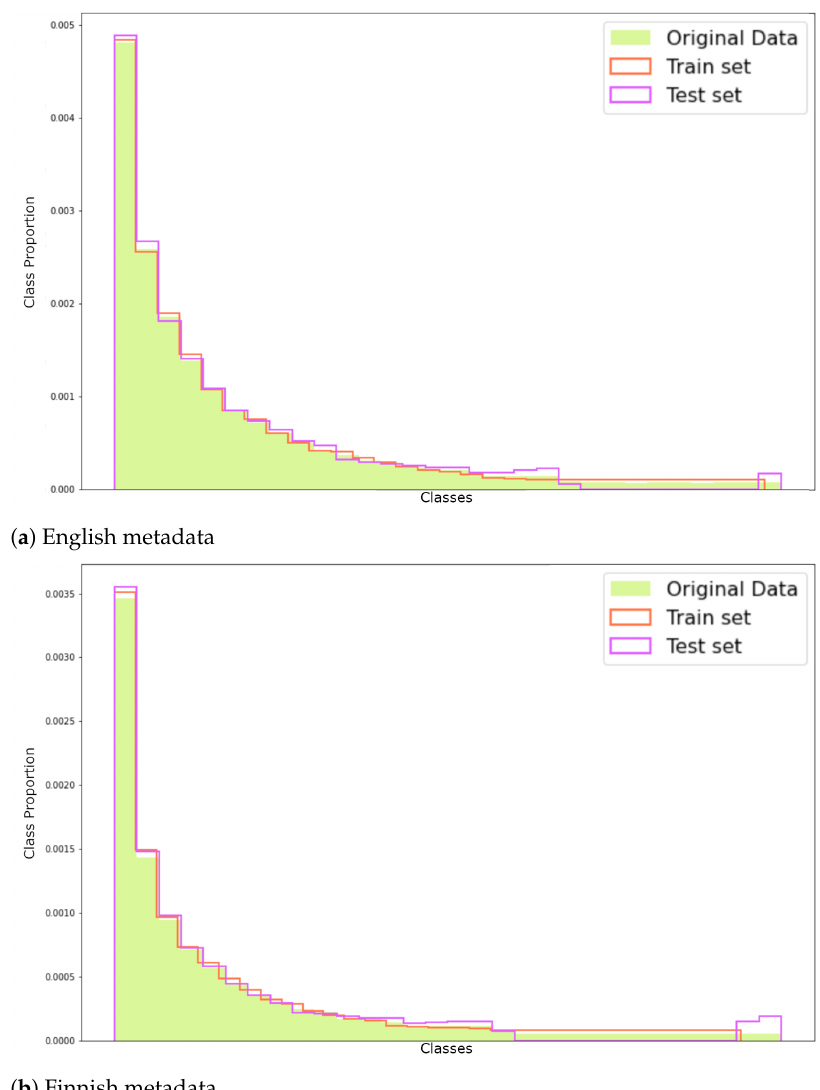
Figure 4. The sorted label distributions on the train and test data sets for the English and Finnish studies’ metadata. The labels are sorted along the horizontal axis, based on their occurrences in the original data. The vertical axis represents the relative class proportion of each respective